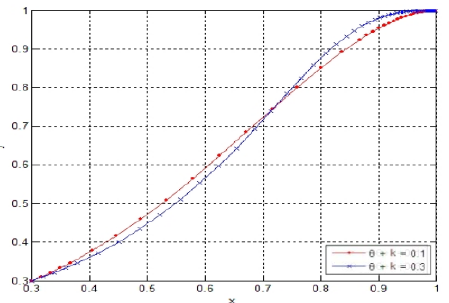
Figure 6. The influence of ( θ + k) changes on the evolution result of the game on both sides of the game.